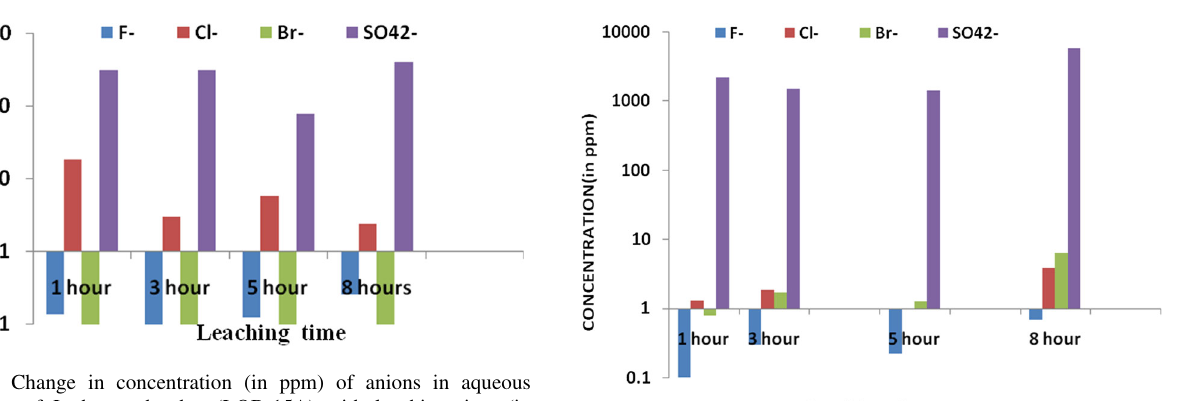
Fig. 13 Change in concentration (in ppm) of anions in aqueous leachates of Ledo overburden (LOB-15A) with leaching time (in hour) at 25 (cid:3) C